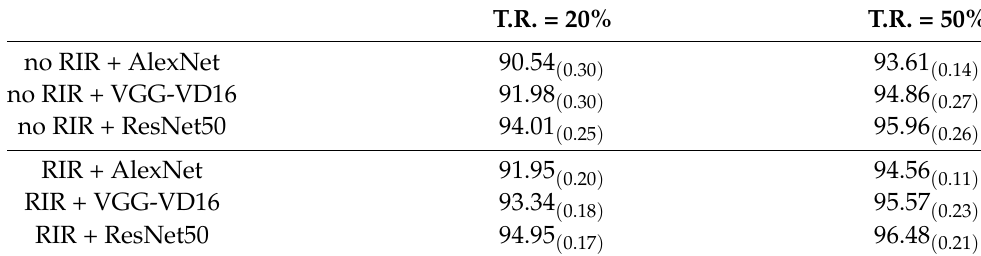
Table 8. Classification accuracies (%) on the AID data